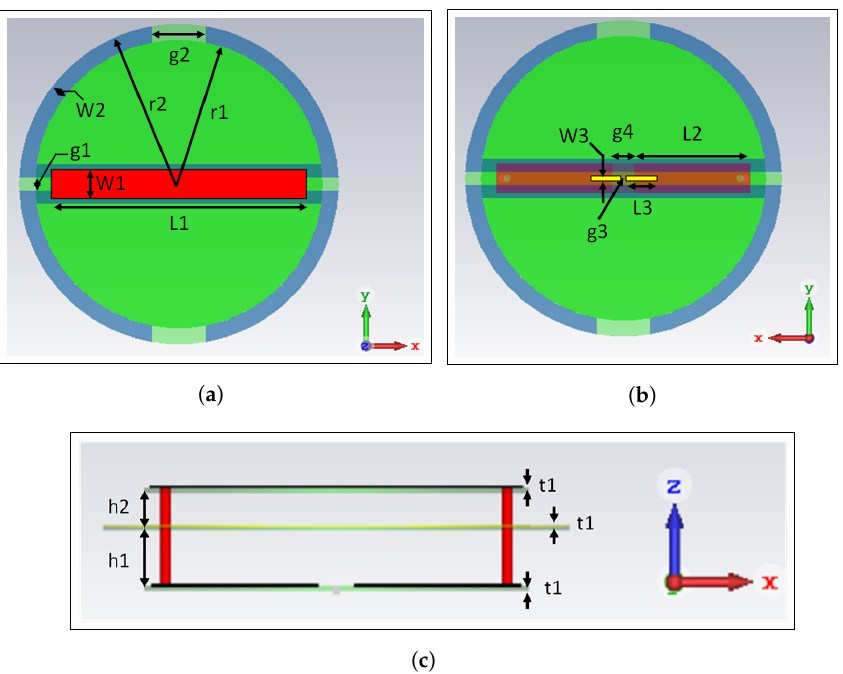
Figure 14. Huygens antenna designed for 5.1 GHz in free space. ( a ) Top view. ( b ) Bottom view. ( c ) Side view. Table 1. Huygens antenna design